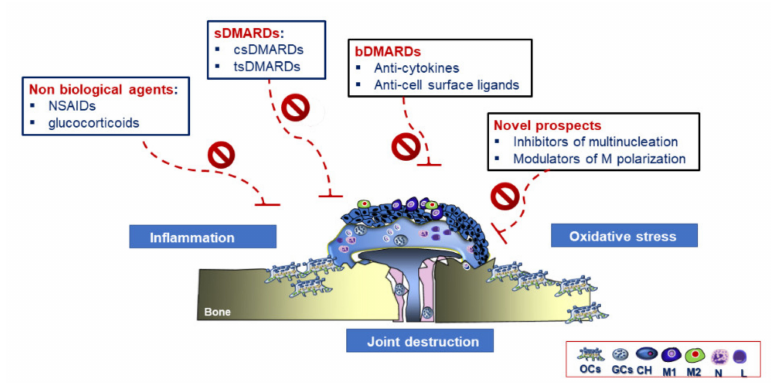
Figure6. GraphicalrepresentationofstandardtreatmentsandnewprospectsforRA.Non-biologicalagents, synthetic disease-modifying anti-rheumatic drugs (sDMARDs), and biological disease-modifying anti-rheumatic drugs (bDMARDs) are among the main standard treatments for RA patients. Using inhibitors of multinucleation and modulators of macrophages (M) polarisation could o ff er alternative novel strategies in